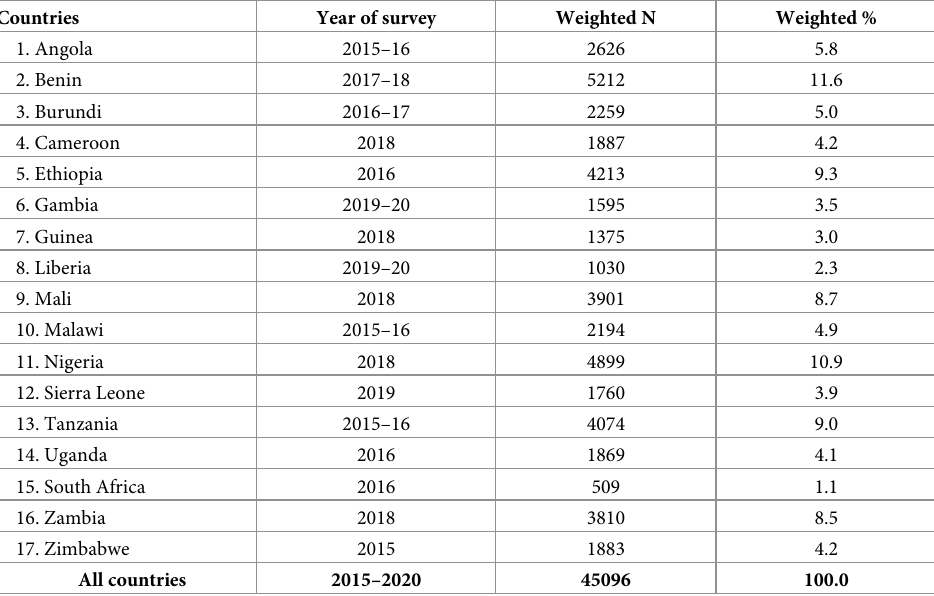
Table 1. Description of the study